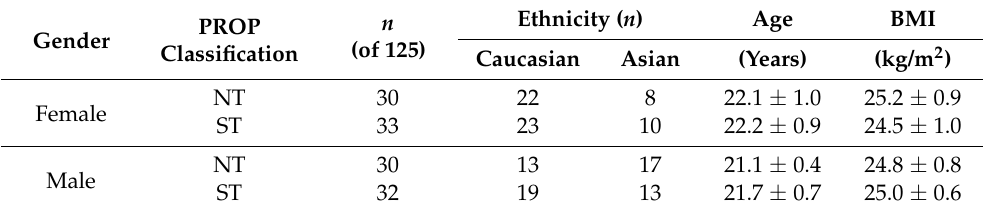
Table 2. Subject